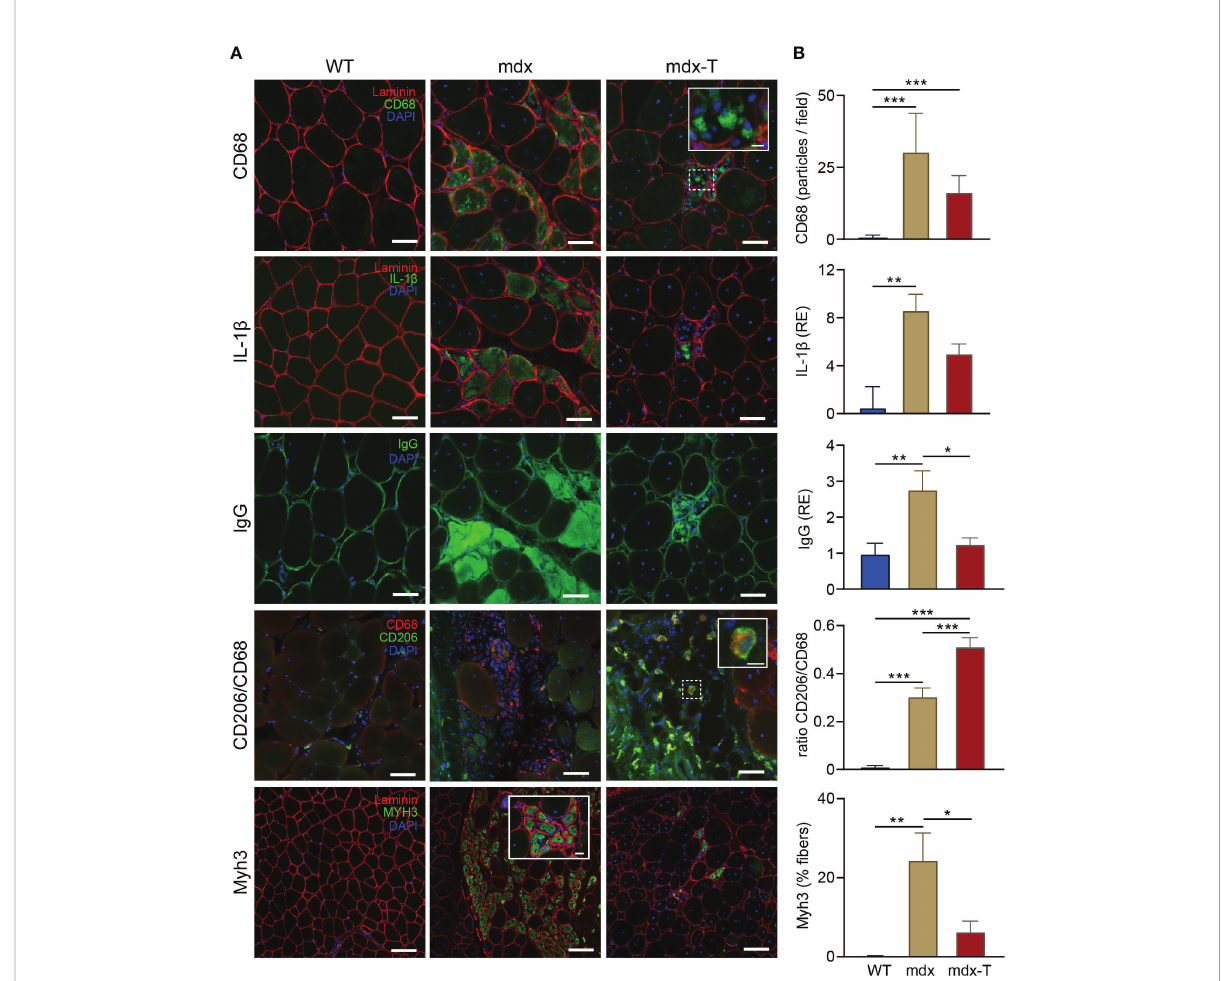
FIGURE 3 MCC950 treatment curbs the accelerated necrosis-regeneration turn-over of mdx mice. Immuno fl uorescence staining was performed in Quadriceps muscle (Q) from the 3 groups of mice. (A) Sections were stained with speci fi c antibodies directed against CD68, IL ‐ 1 b , mouse IgG, CD206 and MyH3 (all in green). Laminin antibody was used to delineate basal membrane (red). Nuclei were counterstained with DAPI (blue). The fi rst three immunolabellings (CD68, IL1- b and IgG) were performed on serial cross sections. Scale bars = 50 m m (CD68, IL-1 b , IgG and CD206) and 100 μm (Myh3). Insets: higher magni fi cation of CD68 + and CD206 + macrophages (scale bars = 10μm) and Myh3 + fi bres (scale bars = 20 μm). (B) Quanti fi cation of CD68, IL ‐ 1 b , mouse IgG, CD206 and MyH3. Results for CD68 and Myh3 are shown as number of positive